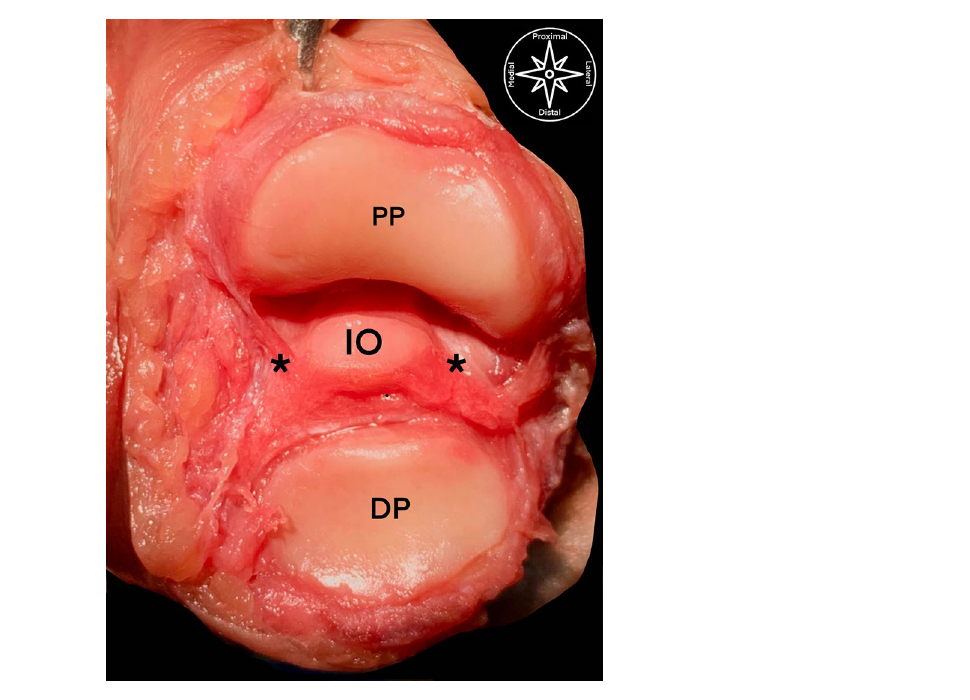
Figure 2. Anatomical dissection of the interphalangeal joint of a right foot from a dorsal aspect: PP proximal phalanx condyle, DP distal phalanx base, asterisk * plantar plate, IO interphalangeal